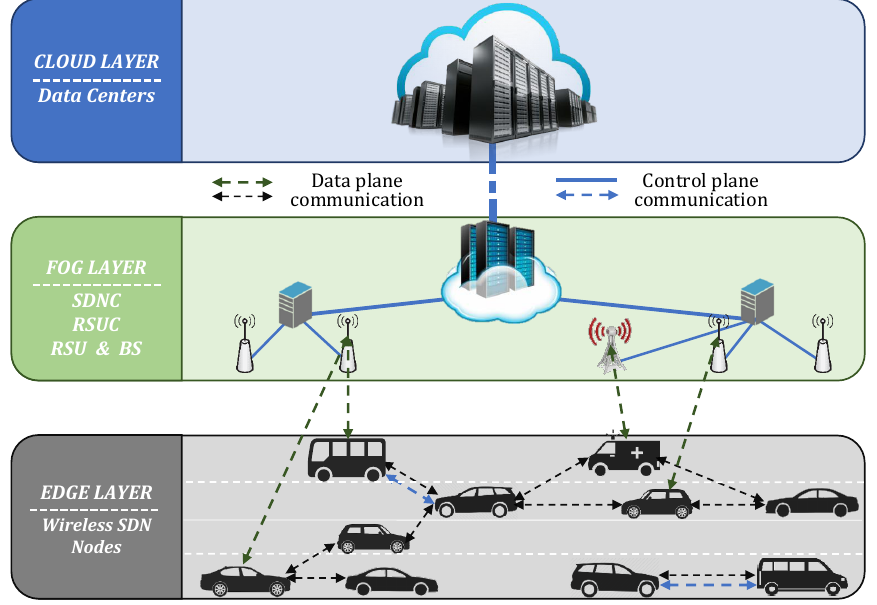
Figure 2. Layered architecture of cloud-fog-edge